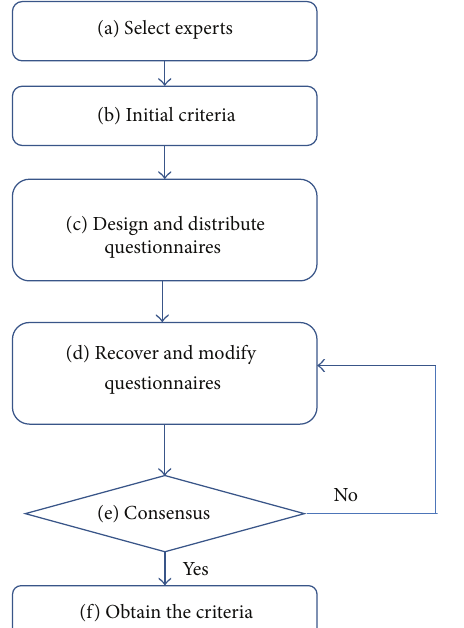
Figure 2: Delphi method operation flowchart.